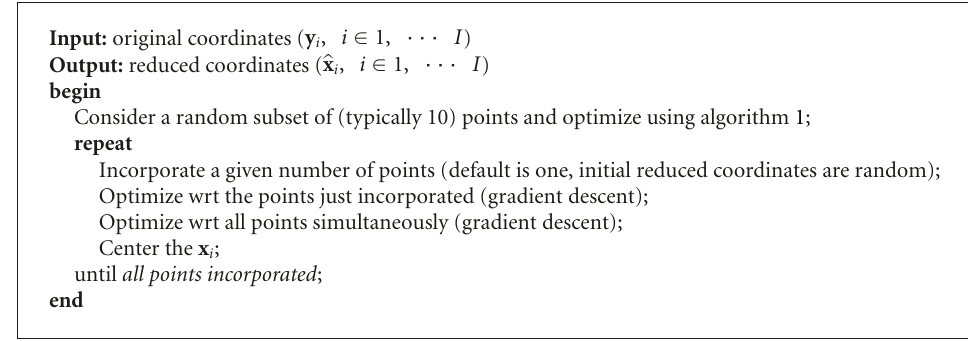
Algorithm 2: Successive incorporation compression algorithm.